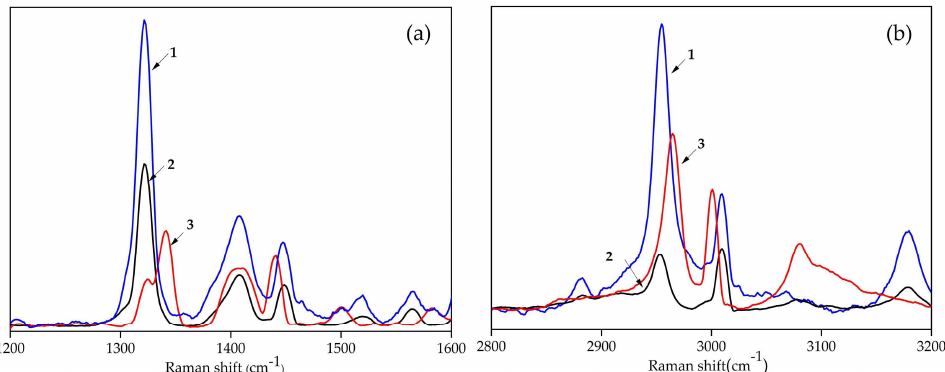
Figure 5. The Raman spectra of glycine before and after absorption on two kinds of anatase (TiO 2 ). ( a ) 1200 − 1600 cm − 1 ; ( b ) 2800 − 3200 cm − 1 . 1: Glycine adsorbed on anatase (TiO 2 ) with exposed (101) facets; 2: glycine adsorbed on anatase (TiO 2 ) with exposed (001) facets; 3: blank glycine.